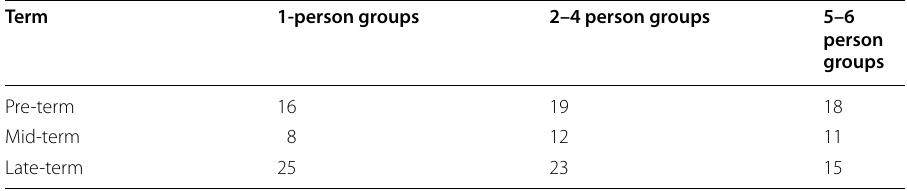
Table 1 Number of participant groups per group size for the pre-, mid- and late-term Term